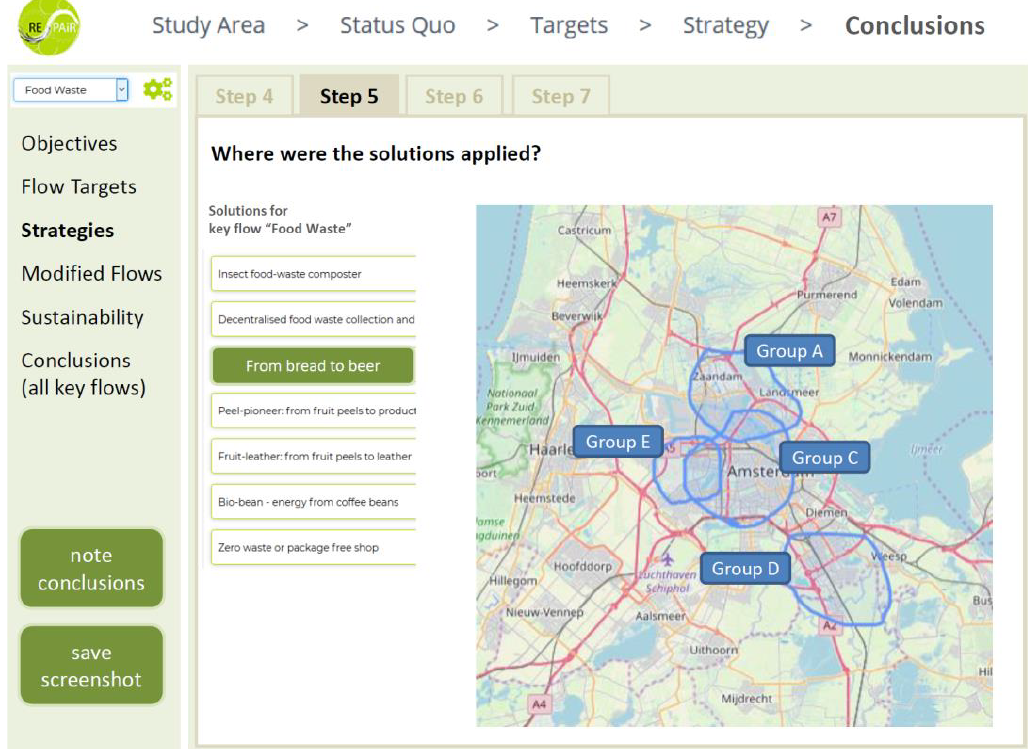
Figure 15. GDSE showing locations of implementations of EIS “from bread to beer”, as drawn by the small groups A, C, D, and